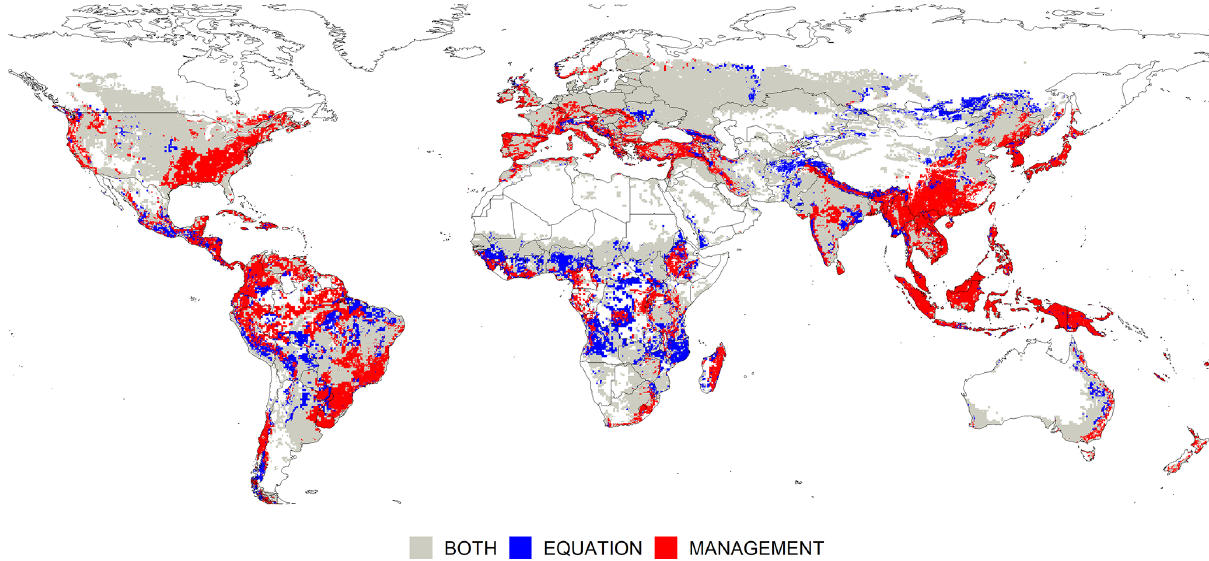
Figure 4. Prevailing uncertainty, defined as the higher uncertainty range by at least 5tha − 1 .